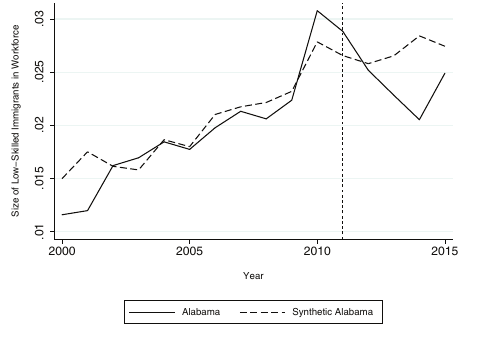
Alabama universal e-verify and share of low-skilled immigrants in workforce